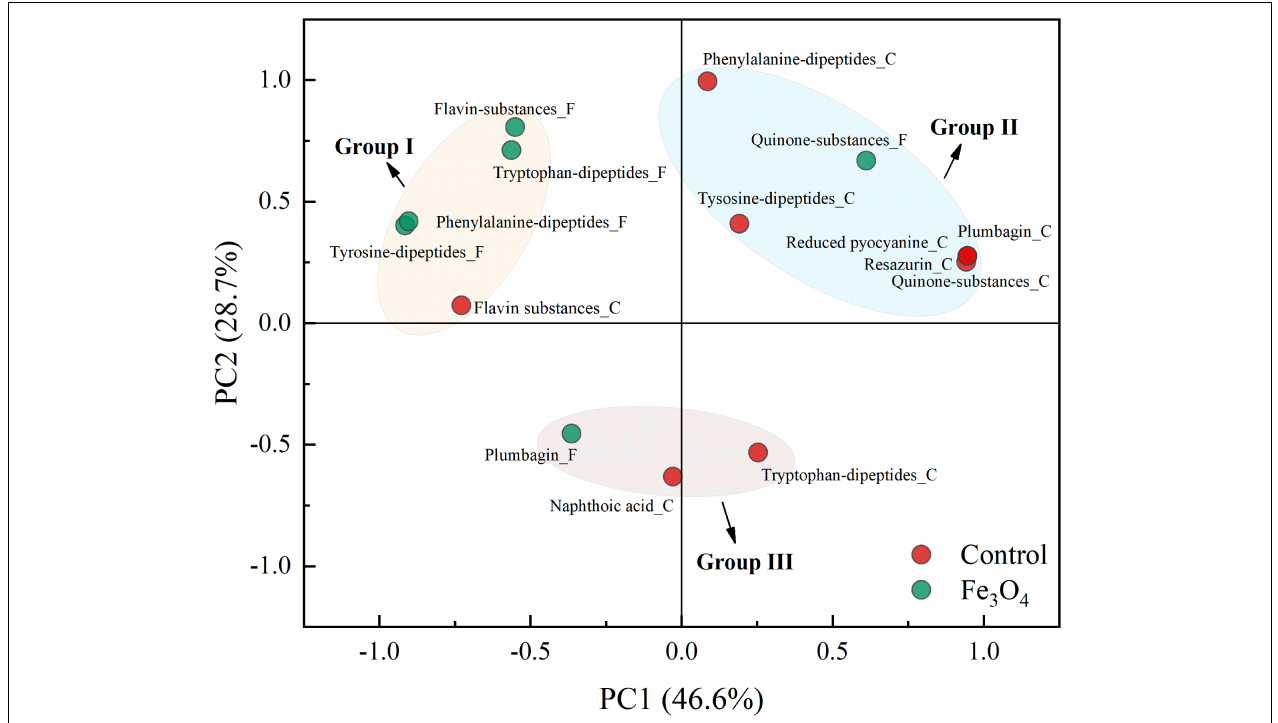
FIGURE 5 | Principal component analysis of dipeptides, quinone substances, and other potential electron shuttles in SMP and EPS